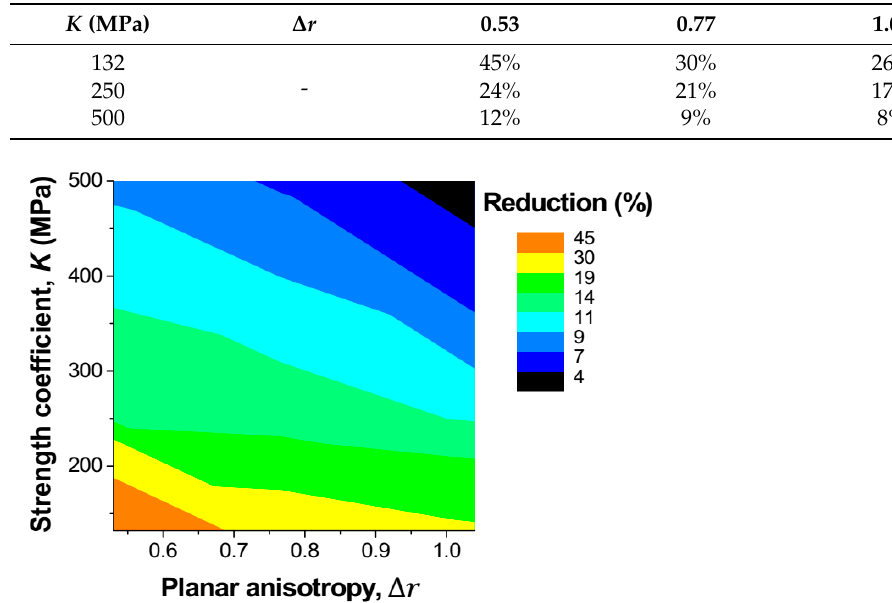
Table 4. Effect of strength coefficient ( K ) and planar anisotropy ( Δ r ) on the reduction of earing height variation by using the varying BHF.